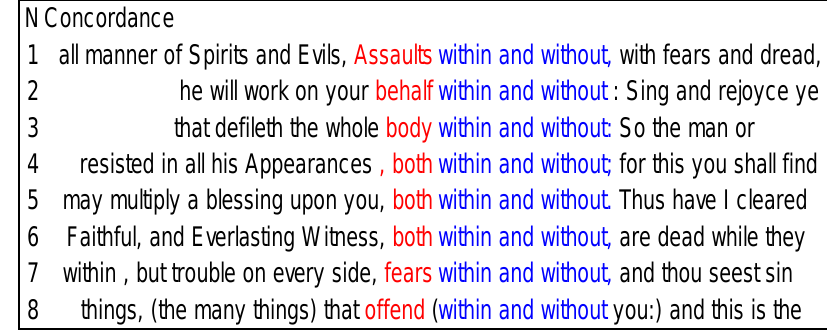
Figure 5. Showing concordance lines for the phrase: within and without , sorted by 1st left.